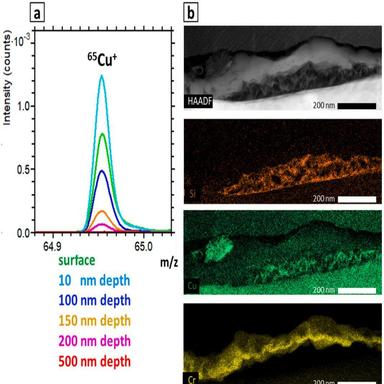
The ToF-SIMS depth profile of Cu+ at the different depths (a) and the HAADF-STEM image of an area of the oxide film and the corresponding Si, Cu, and Cr EDX maps (b).